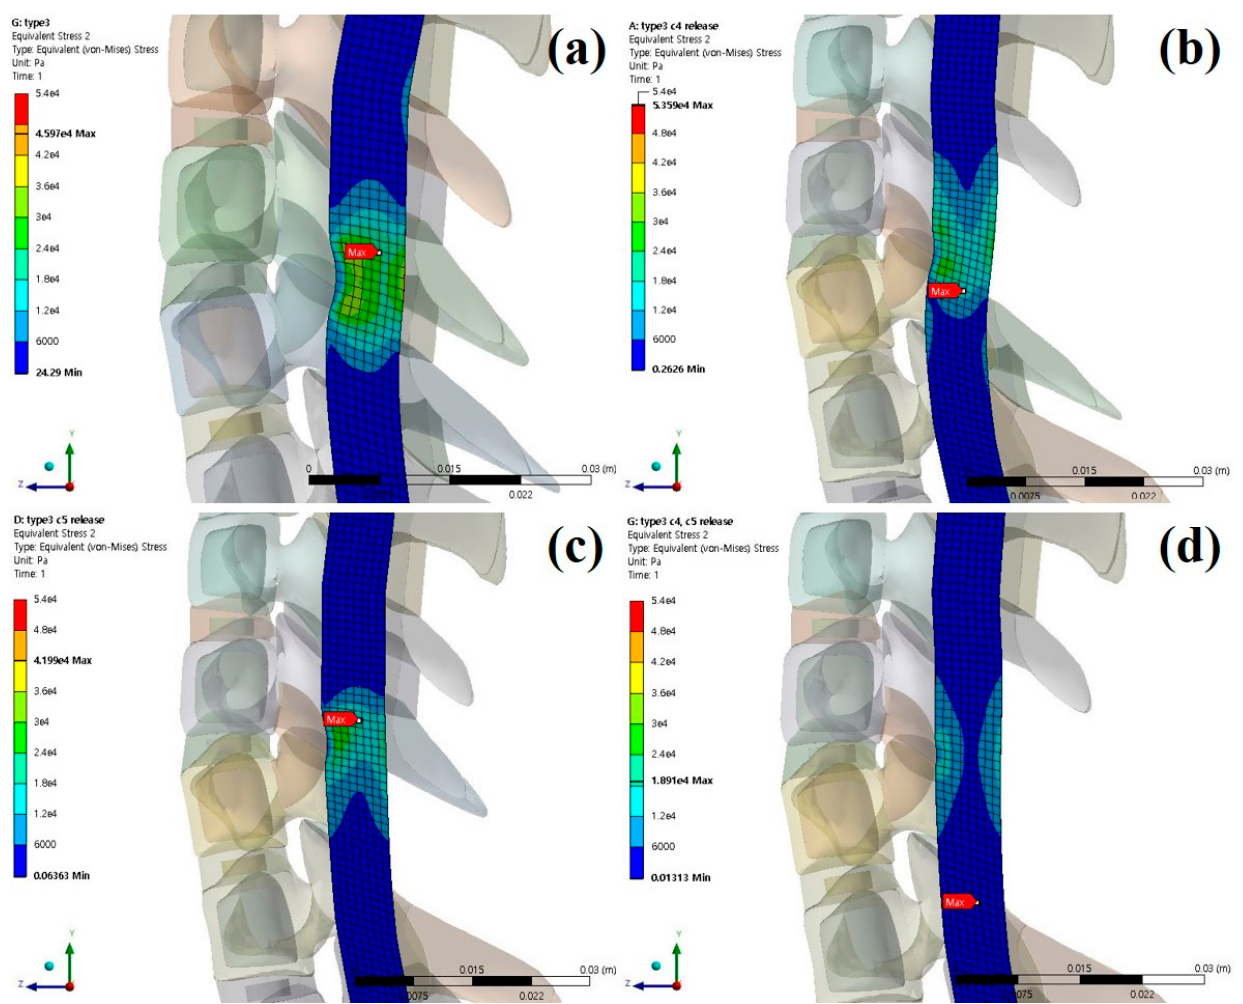
Figure 8. Neutral laminectomy simulation type 3 OPLL: ( a ) non-surgery model equivalent stresses (Pa); ( b ) C4 laminectomy model equivalent stresses (Pa); ( c ) C5 laminectomy model equivalent stresses (Pa); and ( d ) C4-C5 laminectomy model equivalent stresses (Pa). The results of the neutral simulation and decompression are shown in Figure 9 and Tables 4–6.